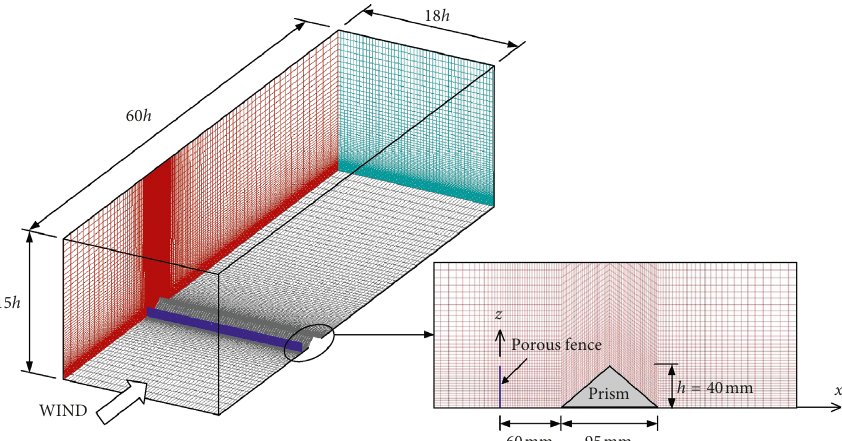
Figure 3: Experimental and numerical mean pressure coefficients along the central line of the flat roof. (a) h (b) h p / H �